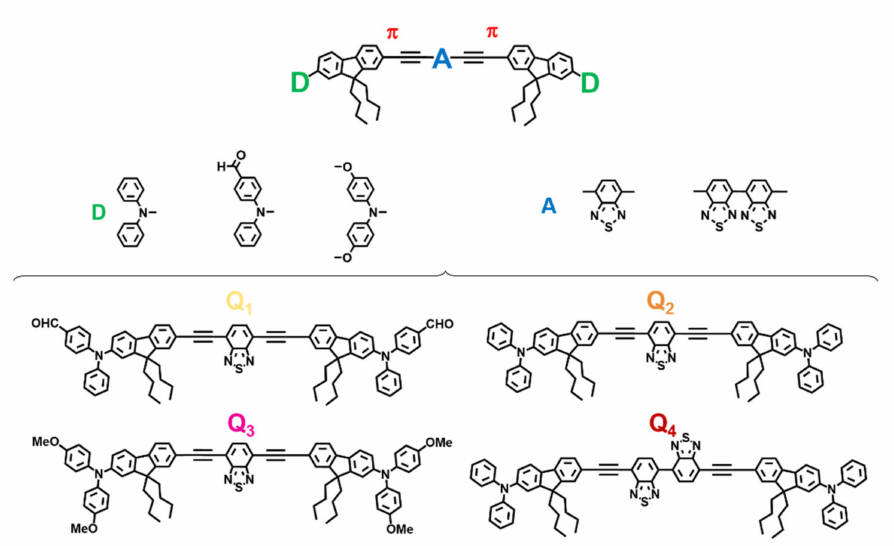
Figure 1. P absorbing quadrupolar dyes as building blocks of stealth